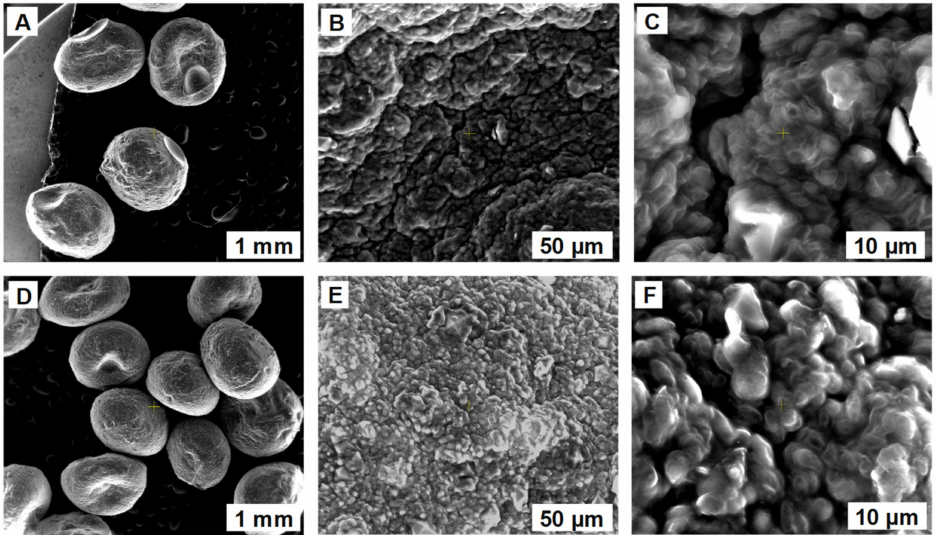
Figure 3. SEM images of SPRBA 5% biosorbent prepared before ( A – C ) and after ( D – F ) biosorption of ethacridine lactate from aqueous solution.